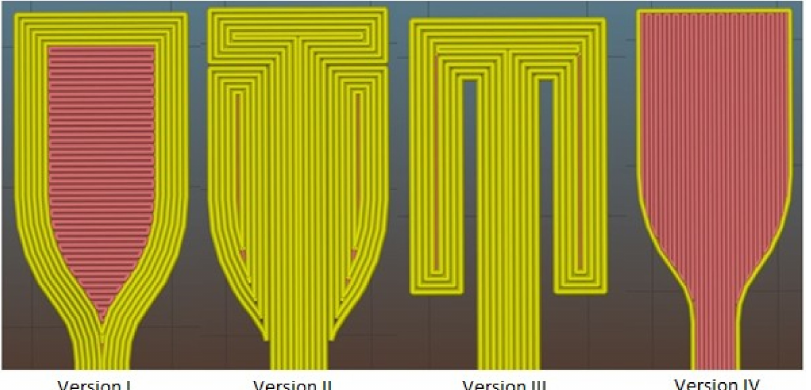
Figure 2. Evolution of three-dimensional (3D) printed dogbones prepared for tensile